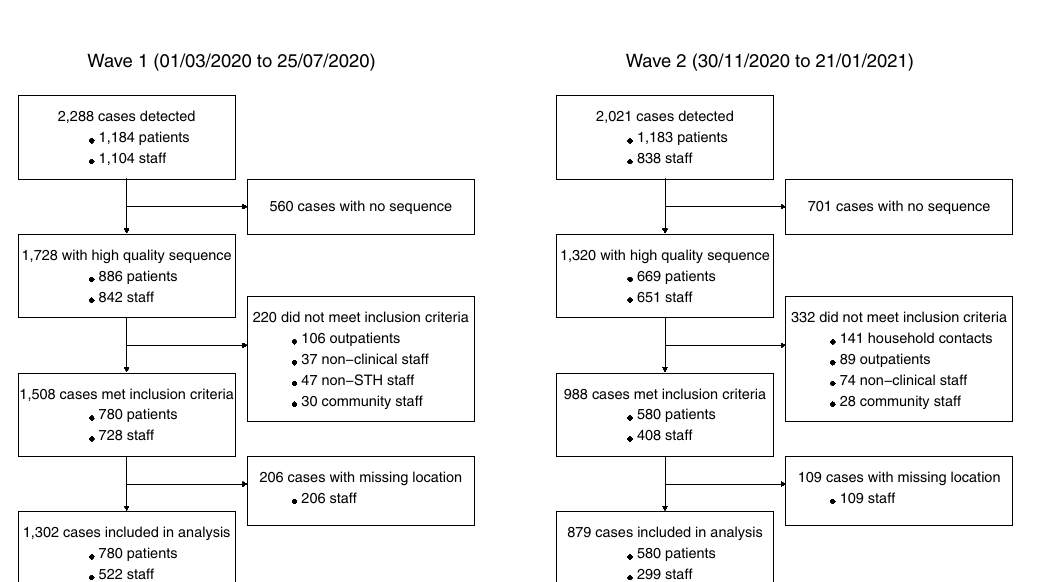
Testing of Symptomatic staff and Level 2 PPE for suspected COVID−19 cases Level 2 PPE for all patient contacts Testing all hospital admissions Testing of asymptomatic staff and patients in outbreak areas Face masks worn in all areas of the hospital Additional patients testing on day 5 of admission